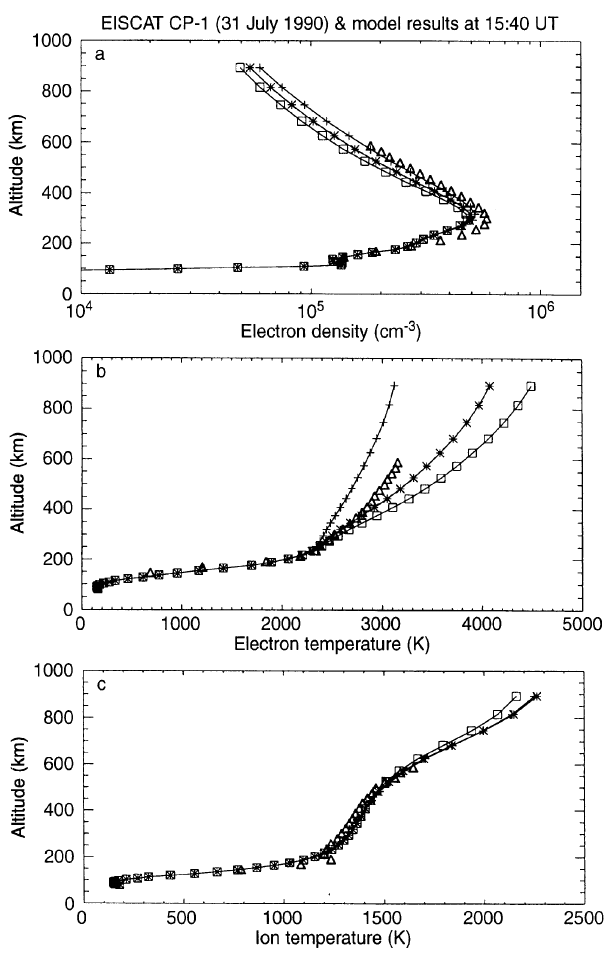
Fig. 9. As in Fig. 8, but showing the influence of varying photo- electron escape energy fluxes with maximum values of 6 (cid:93) 10 (cid:49)(cid:48) eV cm (cid:126)(cid:50) s (cid:126)(cid:49) ( curves with crosses ), 7 (cid:93) 10 (cid:49)(cid:48) eV cm (cid:126)(cid:50) s (cid:126)(cid:49) ( asterisks ) and 10 (cid:93) 10 (cid:49)(cid:48) eV cm (cid:126)(cid:50) s (cid:126)(cid:49) ( squares )